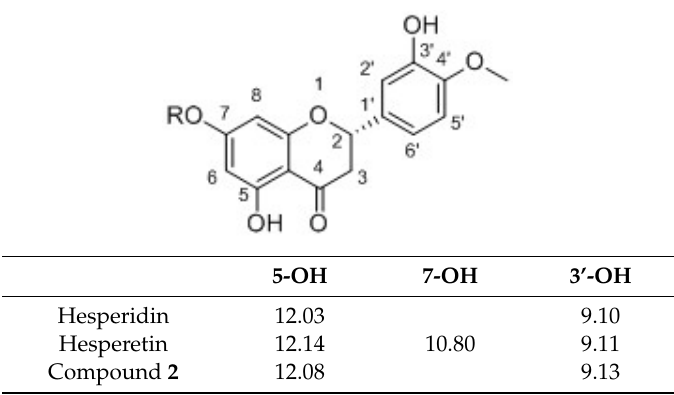
Table 2. Cell viability of RAW 264.7 cells at a compound concentration of 40 μ